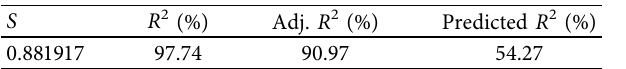
Figure 14: Interaction plot for response. Table 6: Model summary.